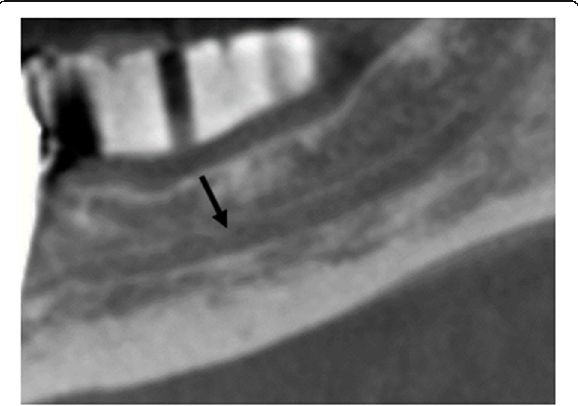
Fig. 2 CBCT: region 36 canal roof